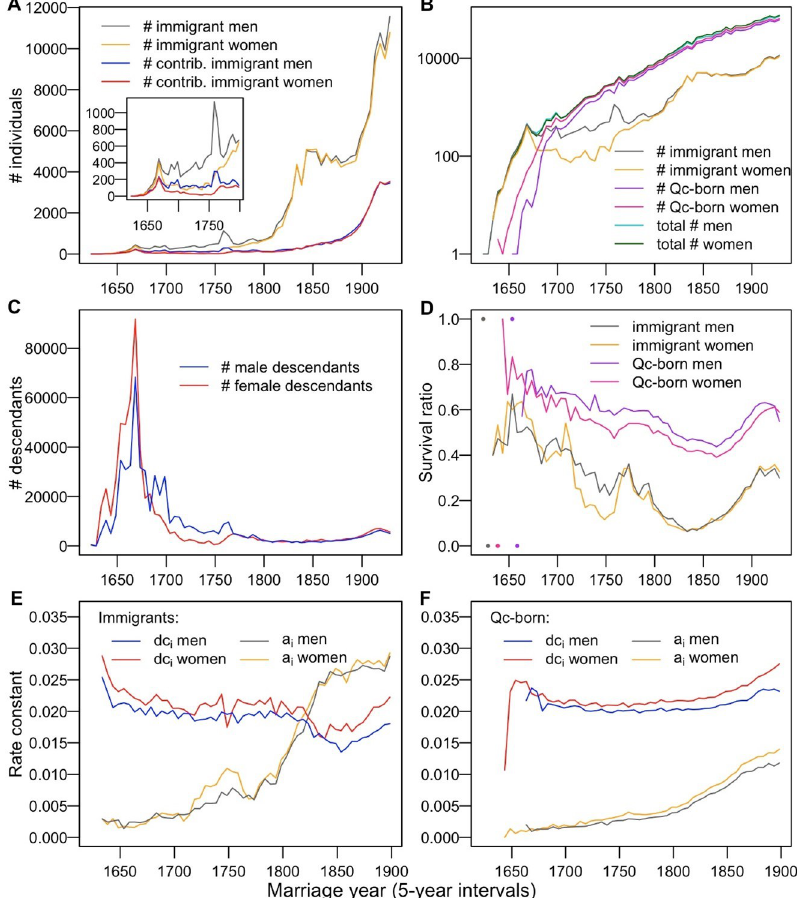
Fig 1. Immigrants, their Quebec-born descendants and related statistics as a function of time. The number of immigrants and their contributing portion at linear scale (inset shows early history at a magnified scale) ( A ). The number of all immigrants, Que´bec-born and their total in logarithmic scale ( B). The number of immigrants’ descendants, Nw i , within the 1931–60 population as a function of immigrants’ settlement time ( C ). Evolution of the survival ratio SR of immigrants and Quebec-born ( D ). Corresponding plots of the net growth ( dc i ) and net extinction ( a ) rates for the immigrants ( E ) and the Quebec-born ( F i